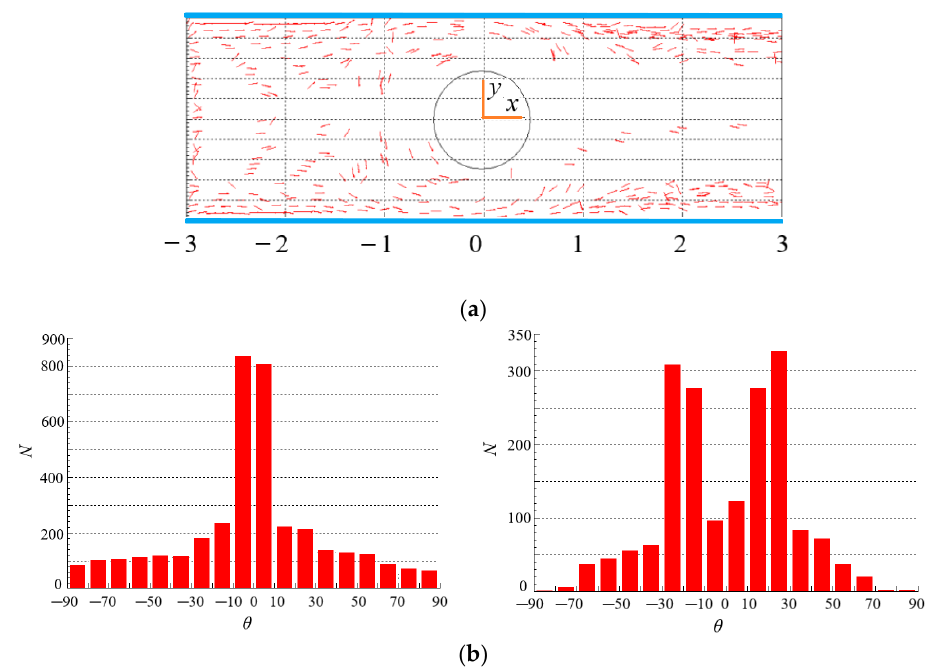
Figure 9. Spatial and orientation distributions of particles at n = 1.3 (Re = 200, β = 8). ( a ) spatial distribution. ( b ) orientation distribution: left: contraction flow ( x < 0); right: expansion flow ( x > 0).